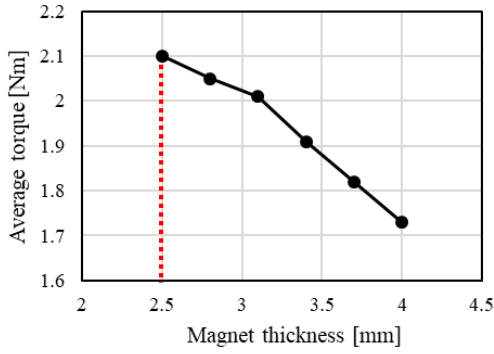
Figure 2. Average torque with respect to magnet thickness.